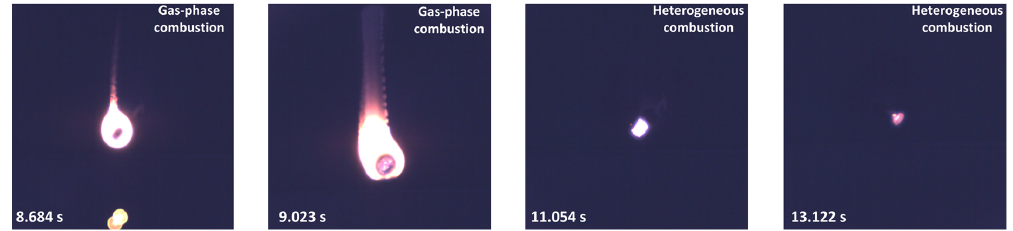
Figure 2. Frames of slurry fuel (90% filter cake, 10% straw) combustion.